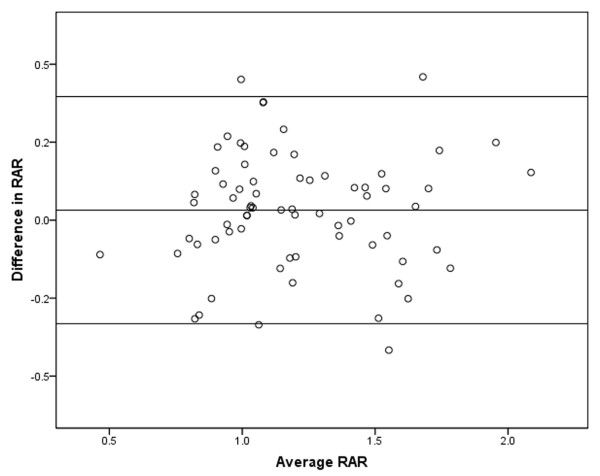
Bland Altman plot of the RAR values. Bland-Altman analysis showed excellent inter-observer agreement for the RAR.